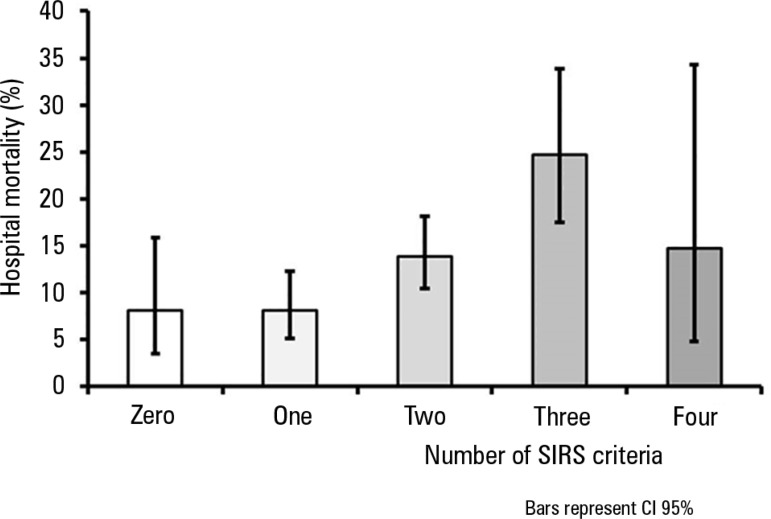
Mortality according to the number of systemic inflammatory response
syndrome criteria that were met.SIRS - systemic inflammatory response syndrome; CI95% - confidence
interval 95%.